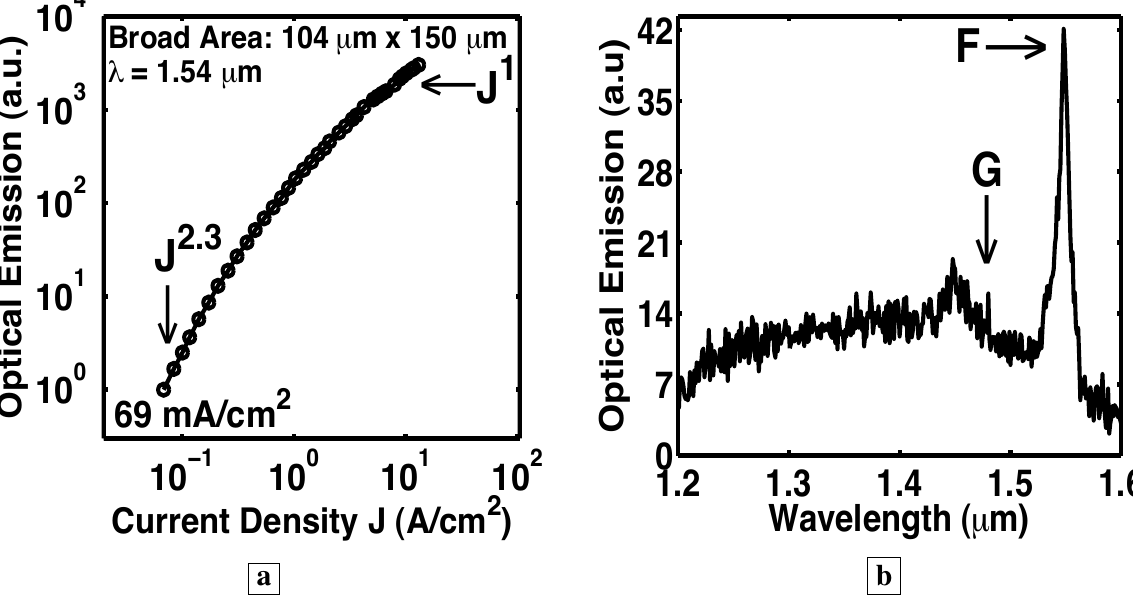
Figure 18 . Room-temperature measurements [5] in cw-mode from a resonant cavity with both a bottom DBR and RIE facets. a, The stimulated-emission at 1.54 µ m from Sample M is seen to rise as J 2 . 3 , beyond which the optical-emission quickly becomes linear in J. The threshold current density is observed to be less than 69 mA/cm 2 . b, Optical-emission spectrum from Sample M at 7 A/cm 2